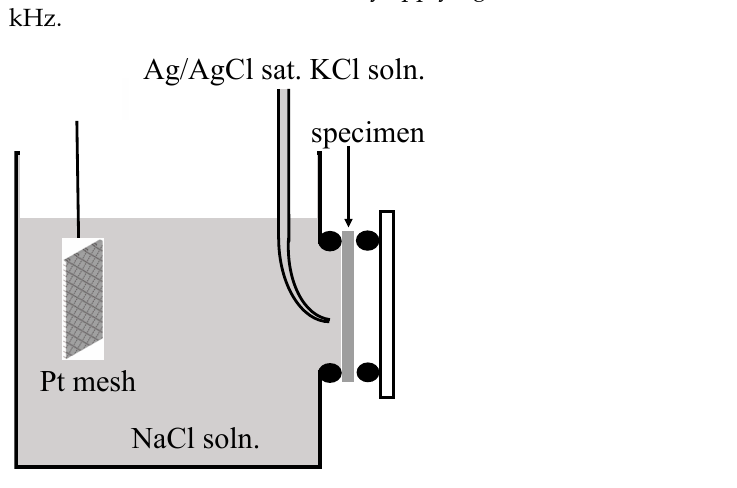
Figure 1. Schematic diagram of electrochemical cell used for electrochemical impedance